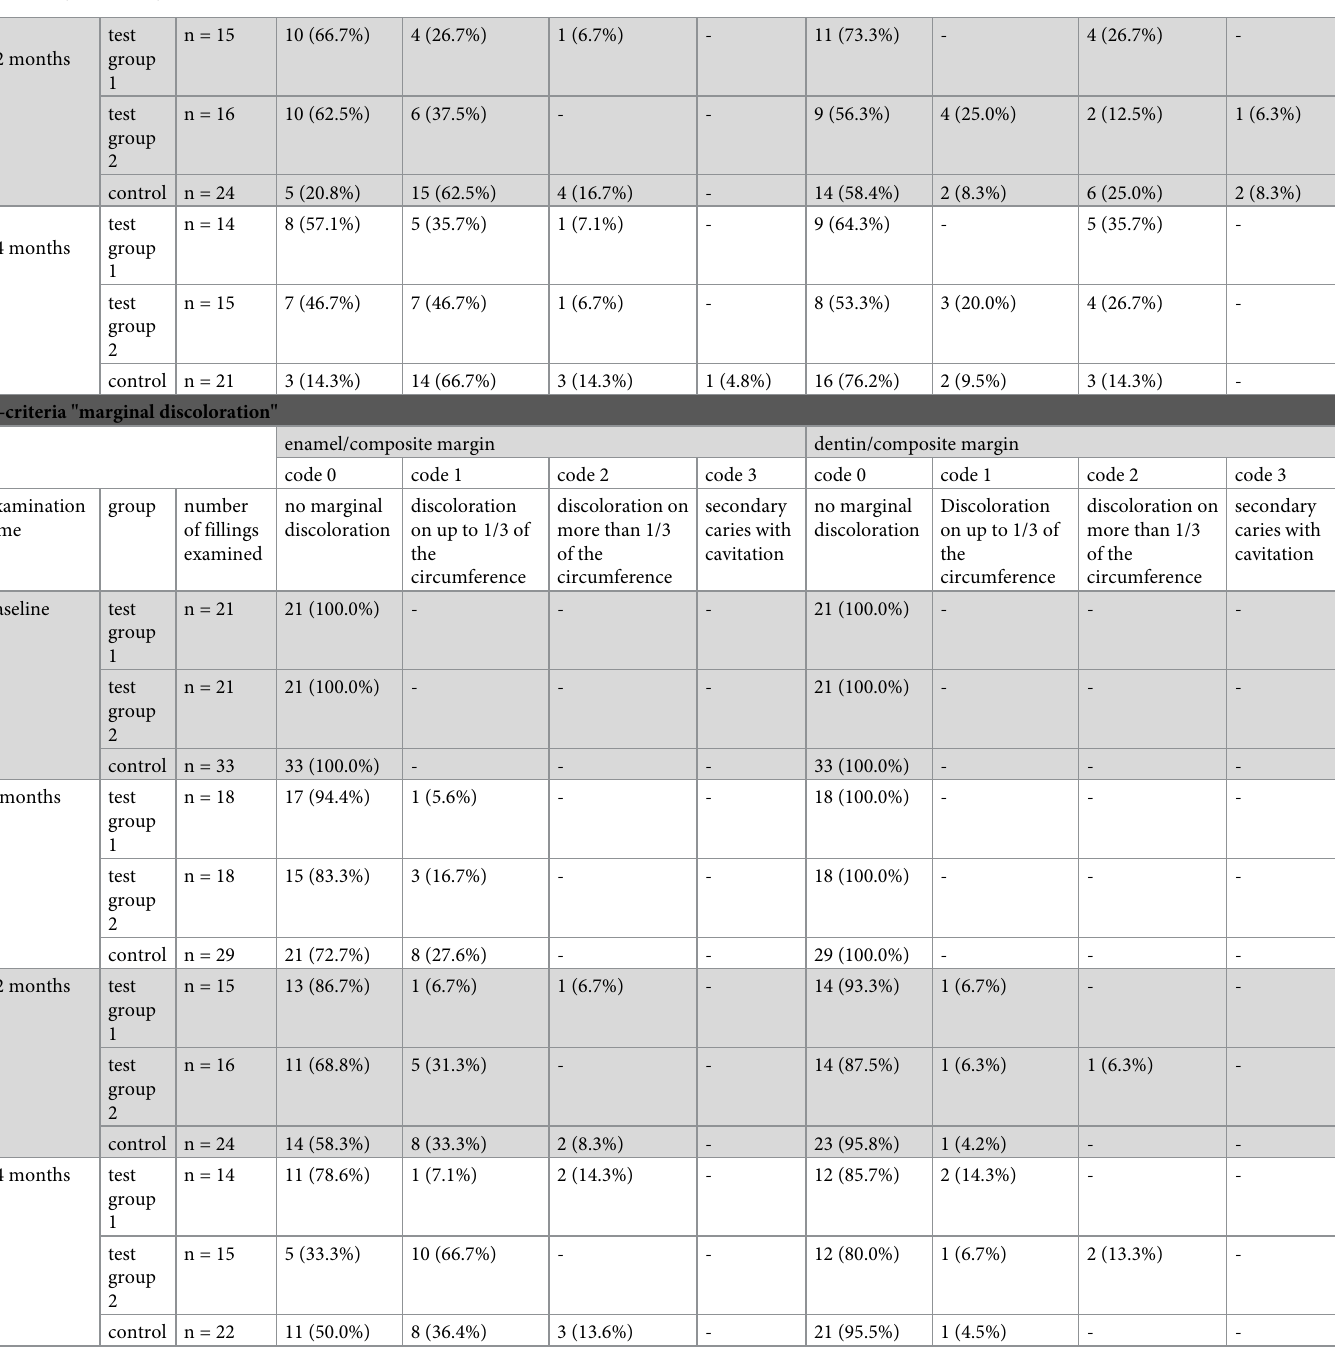
Results of the examined C-criteria (marginal integrity, marginal ledge formation, degree of marginal discoloration) according to the CPM-Index assessed for the composite-enamel and composite-dentin